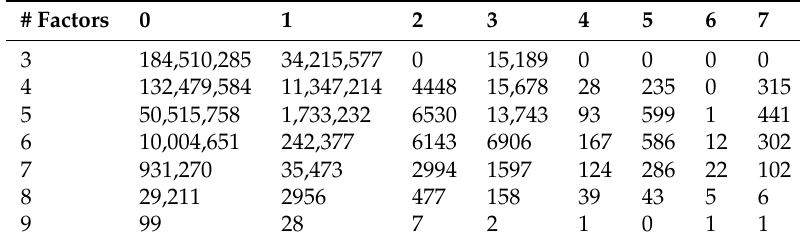
Table 6. Factor distribution of idempotent factorizations < 2 30 (<8